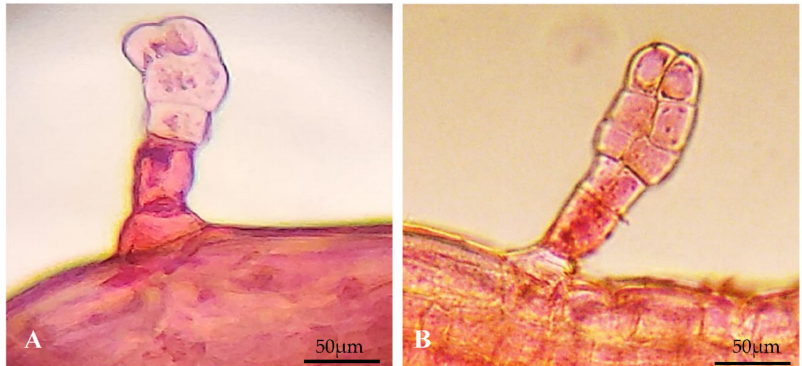
Figure 4. Microscopic structure of trichomes in the leaves of ( A ) regenerated and ( B ) mother plants (bar = 50 µ m).